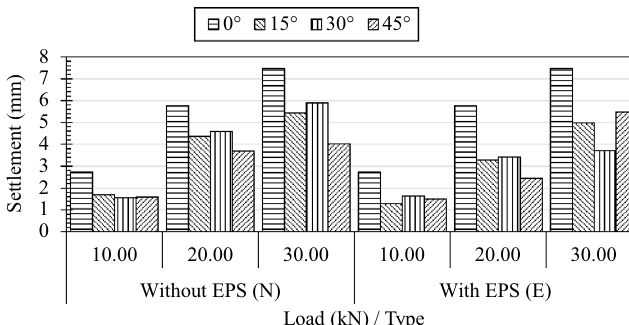
Fig. 13 Settlement at certain loading points for folded footings with and without EPS